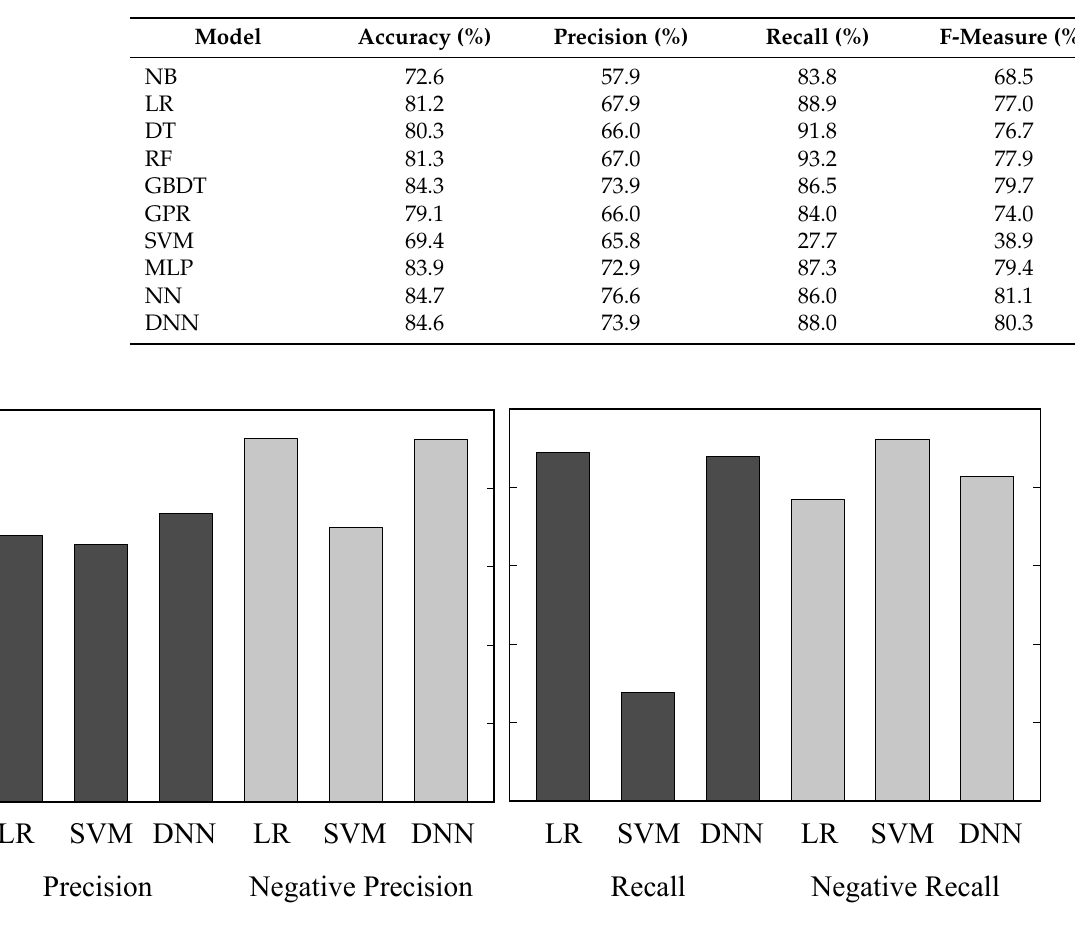
Table 8. Comparison of machine learning models using all features.